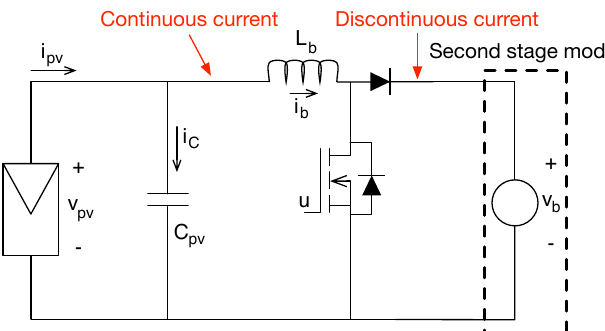
Figure 4. PV system based on the classical boost